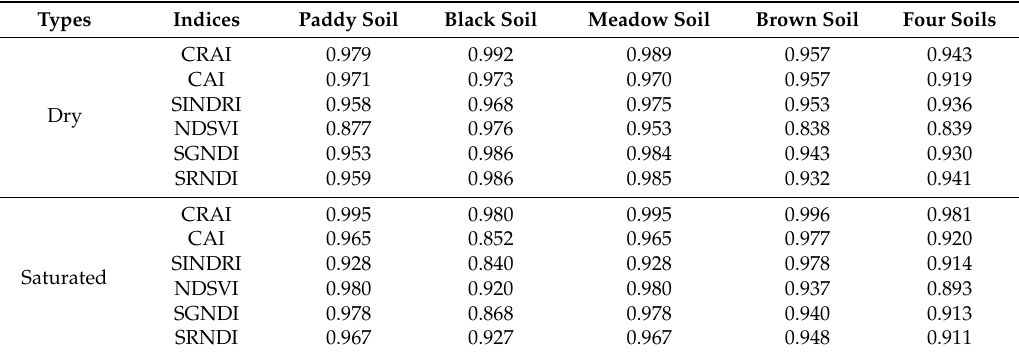
Table A3. Absolute value of correlation coefficient.